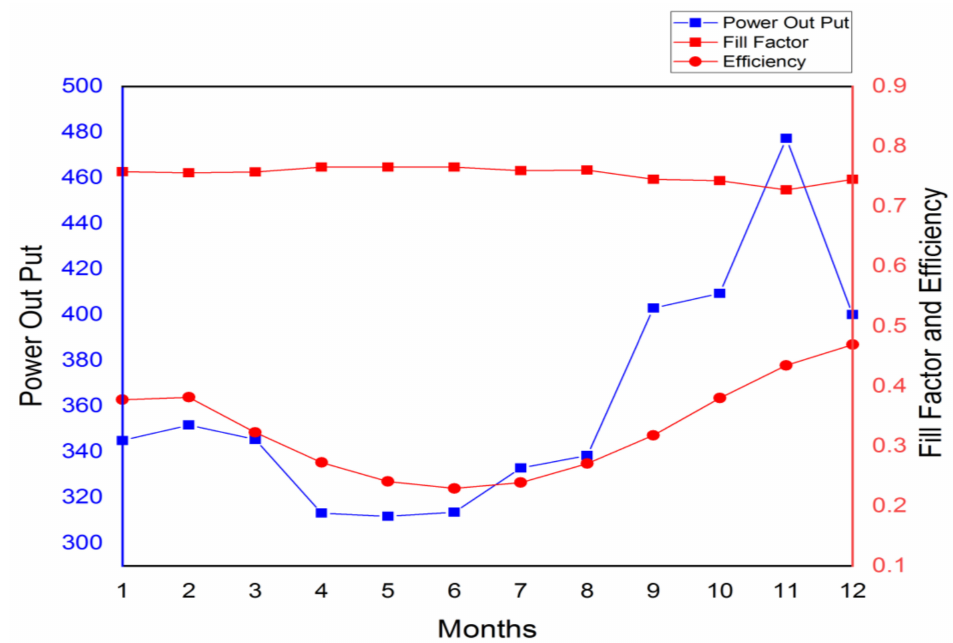
Figure 10. Power, efficiency, and FF at an optimal fixed tilt angle (29.5 ◦ ), by